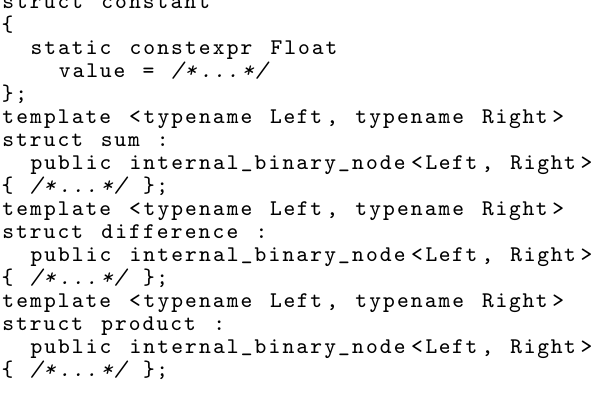
Figure 1. Templates for the representation of expression